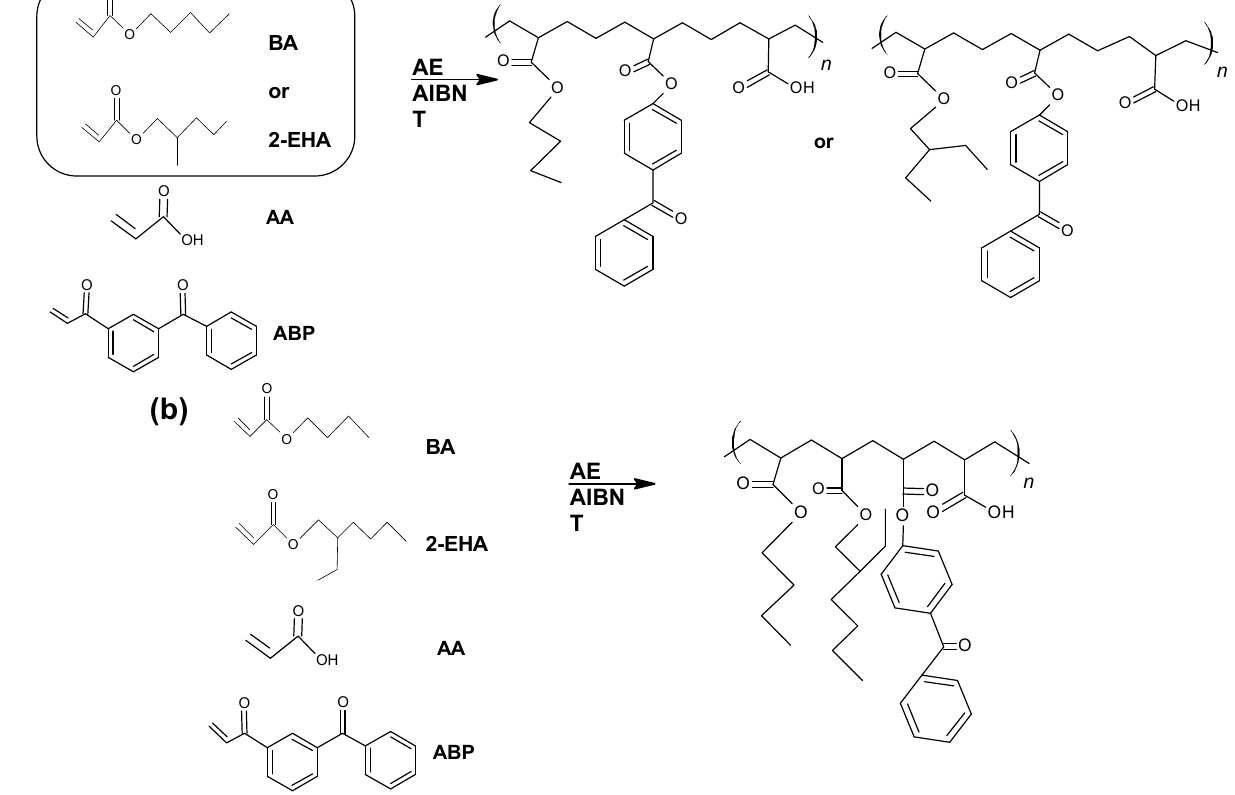
Figure 1. Schematic presentation of the performed syntheses and theoretical structures of the synthesized copolymers (( a ) P1 and P2, ( b ) P3). (AE-ethyl acetate).